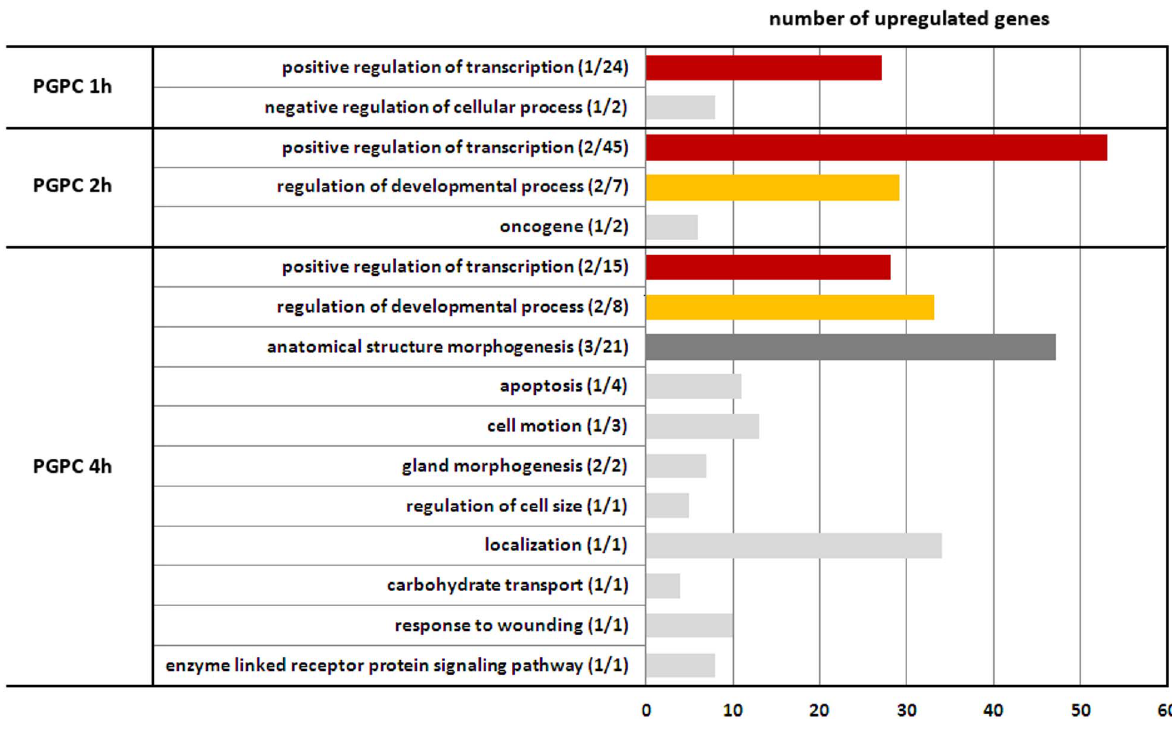
Figure 1. Time dependent effects of PGPC on gene expression in RAW 264.7 macrophages. An annotation term clustering with annotation terms referred to biological processes of upregulated genes was performed with DAVID. Dominant biological processes were classified applying analysis steps described in ‘‘Materials and Methods’’.